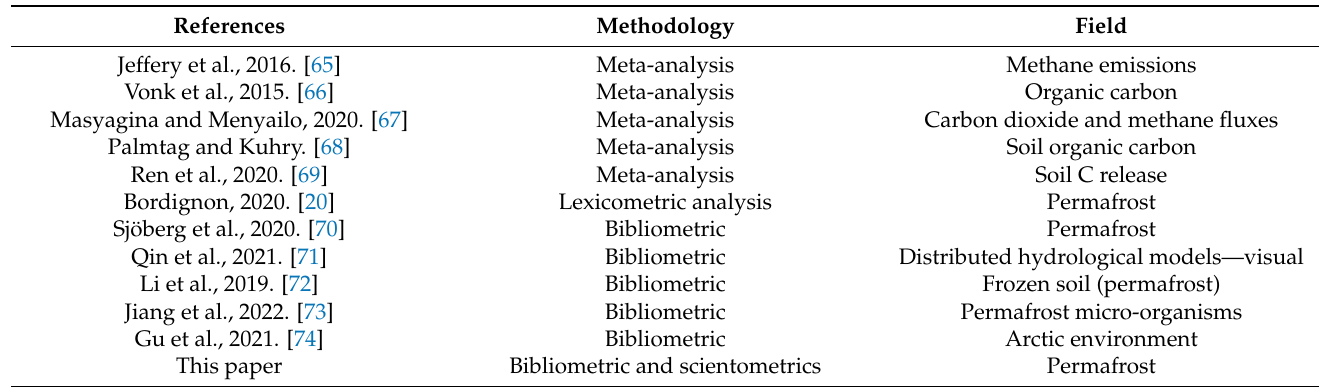
Table 1. List of the previous bibliometric studies related to